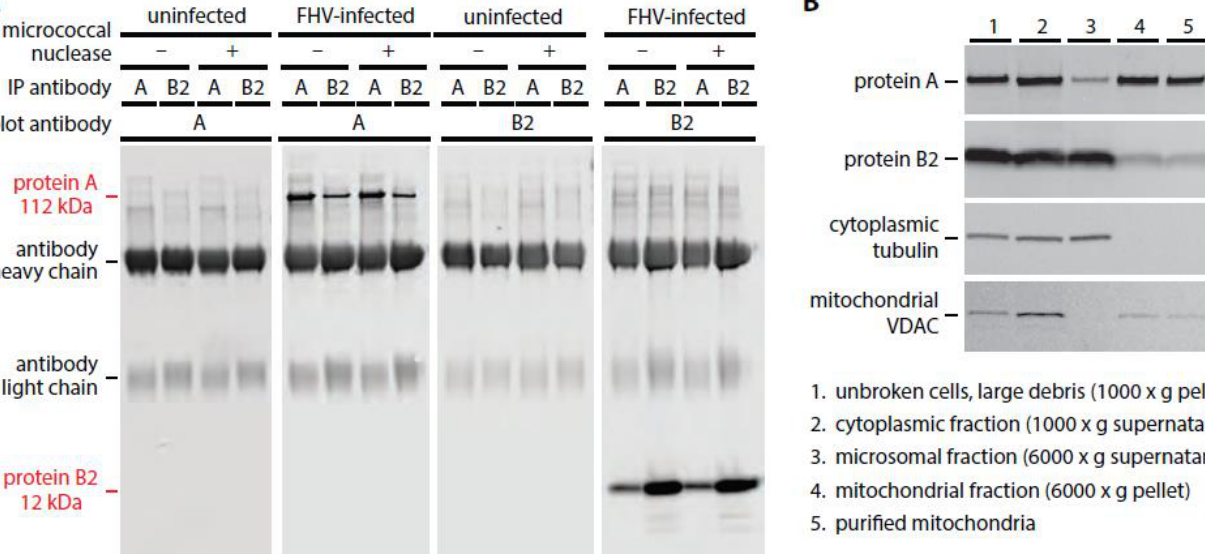
Figure 3. Small amounts of protein B2 interact with protein A and segregate with purified mito- chondria. ( A ) Subsets of nodavirus proteins A and B2 physically interact. Antibodies directed against protein A co-immunoprecipitate protein B2 and antibodies directed against protein B2 co-immunoprecipitate protein A. The interaction is insensitive to micrococcal nuclease treatment, showing that it is not mediated through RNA. ( B ) Cell fractionation procedures to isolate mitochon- dria show that the majority of protein A but only a small amount of protein B2 (~8%) tracks with mitochondrial marker VDAC, while the great bulk of protein B2 tracks with cytoplasmic tubulin.